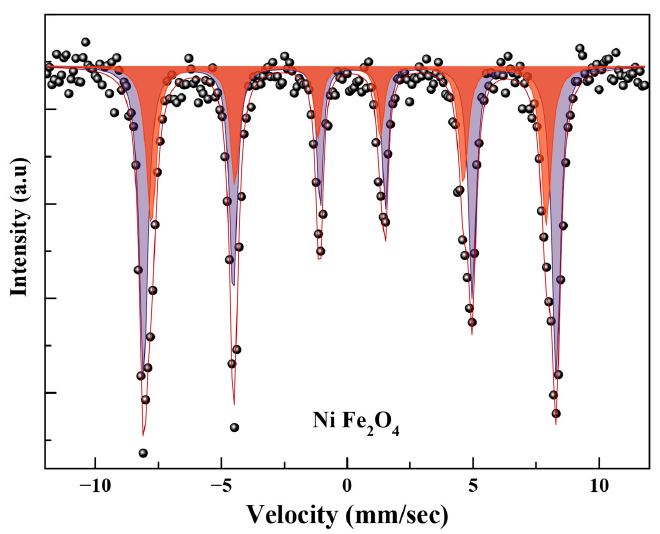
Figure 7. Mössbauer spectrum of spinel NiFe 2 O 4